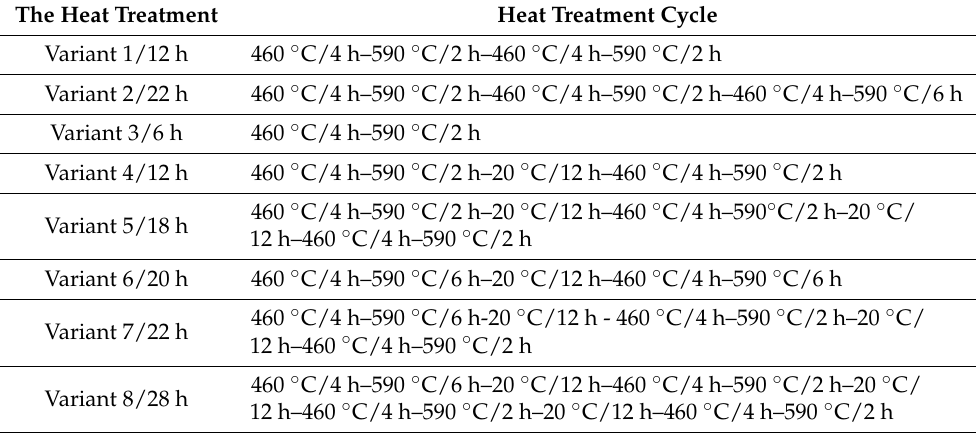
Table 3. Variants of annealing of nitrided samples made of WNLV steel for electron-microscopic examinations.